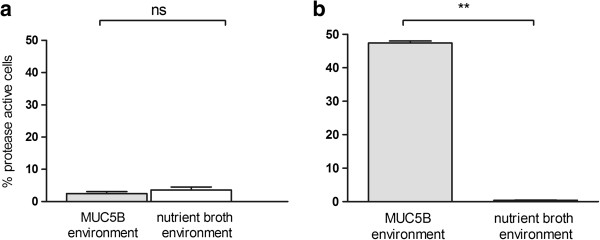
Proportion of proteolytically-active Lactobacillus fermentum cells in planktonic and biofilm culture. Graphs showing the percentage of proteolytically active cells in populations of (a) planktonic or (b) biofilm cells of L. fermentum in a MUC5B- or a nutrient broth-environment as revealed using a fluorescent substrate combined with CSLM. The bars represent the mean value of three independent experiments ± SE (** p < 0.01).